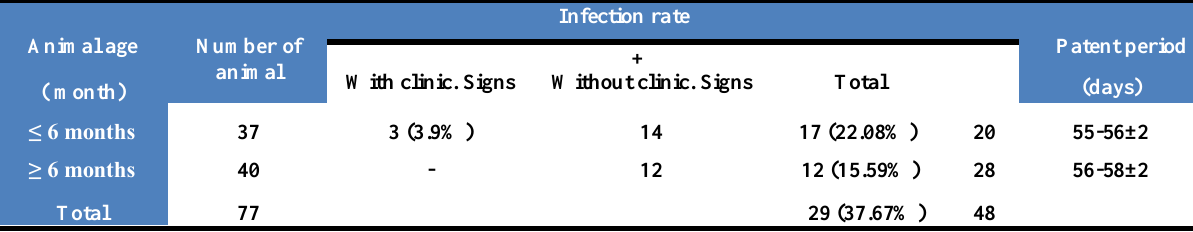
Table, 1: Eimeriosis infection rate of local meriz ( Capra ibex ) goats. Animal